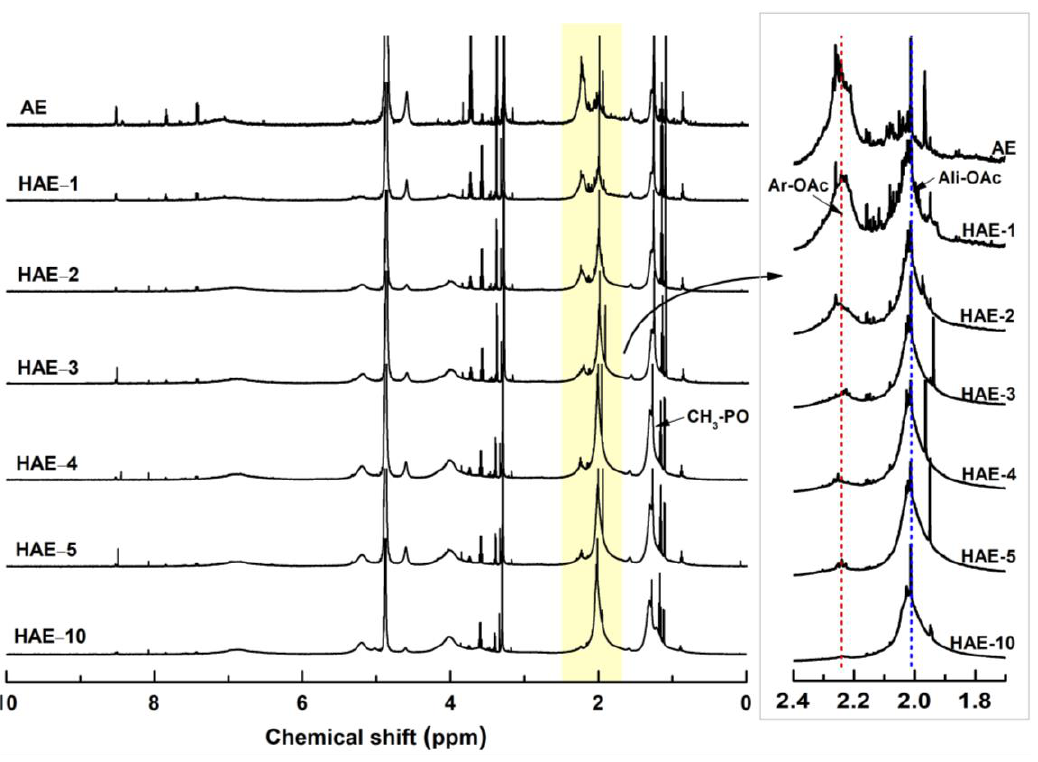
Figure 4. 1 H NMR spectra of acetylated AE and HAEs. Ar-OAc: aromatic acetate, Ali-OAc: aliphatic acetate.